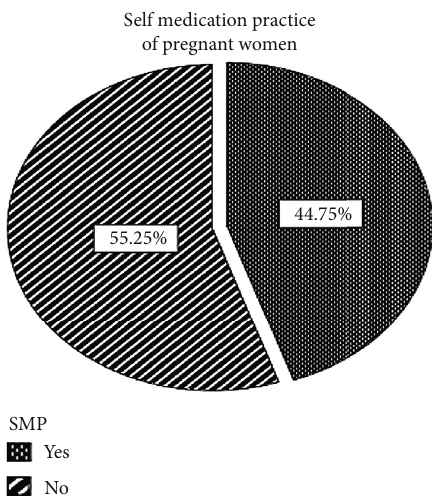
Figure 1: Self-medication of pregnant women at UoGCSH, June